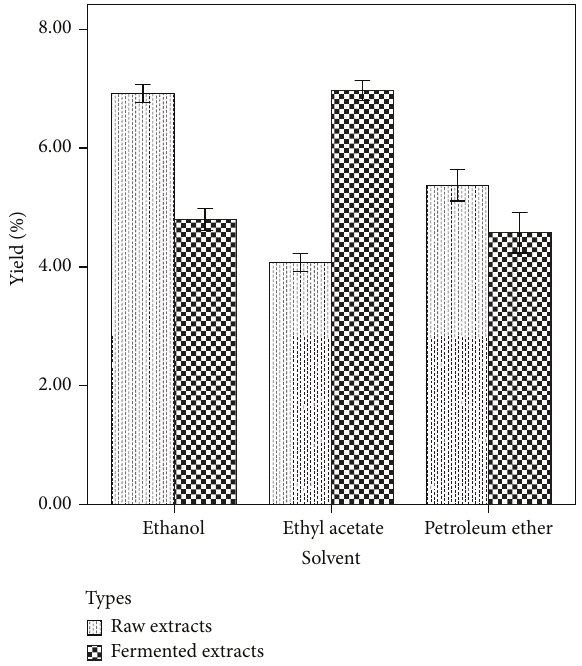
Figure 1: Percentage yield of extracts obtained from raw and fermented Lenzites quercina with different solvents.